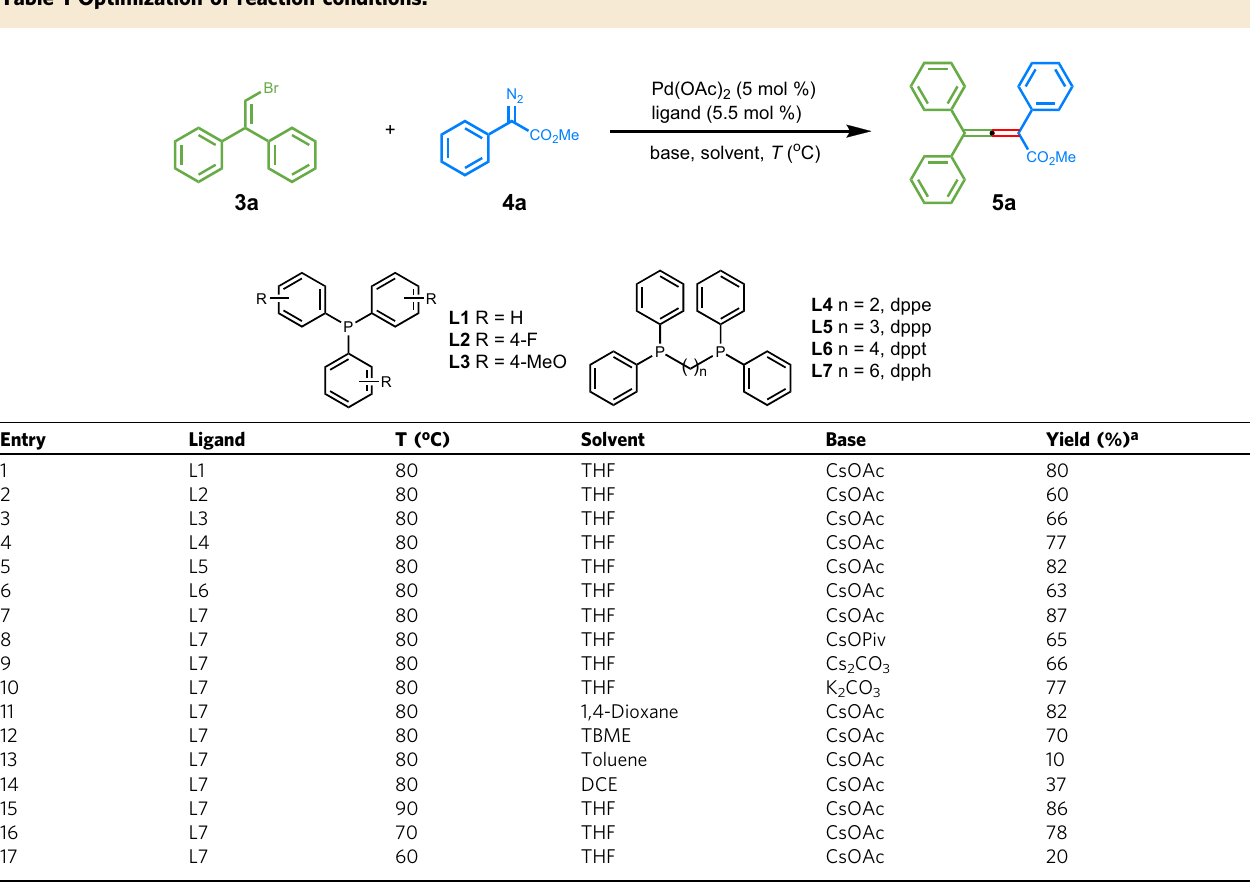
Table 1 Optimization of reaction